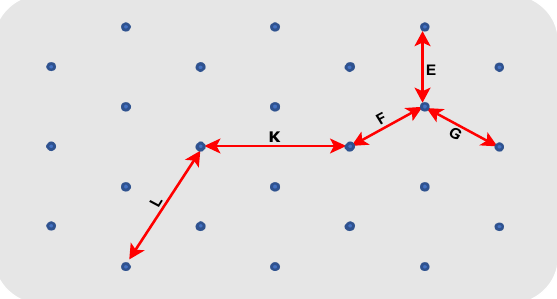
Figure 1. A regular hexagonal layout of turbines with hexagonal side = 7 D